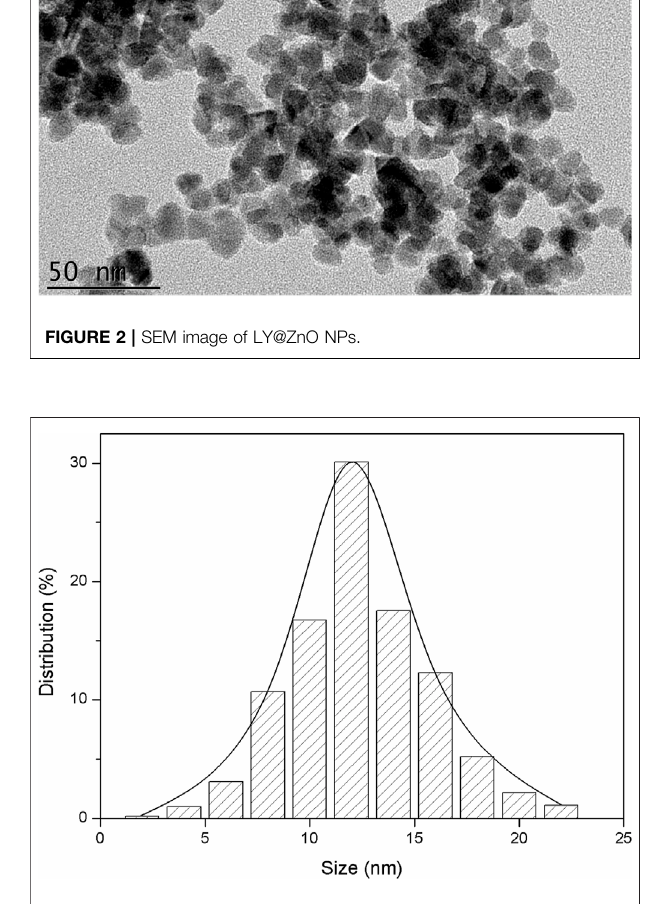
FIGURE 3 | Nanoparticle size measurement result of